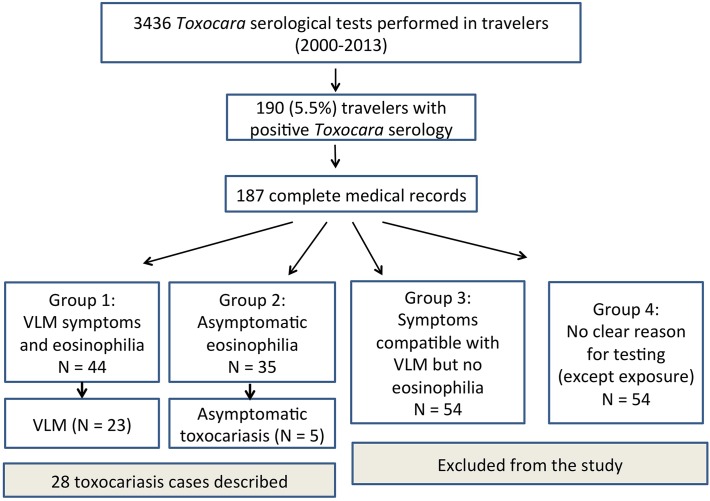
Flow chart and distribution of study participants (VLM: visceral larva migrans).